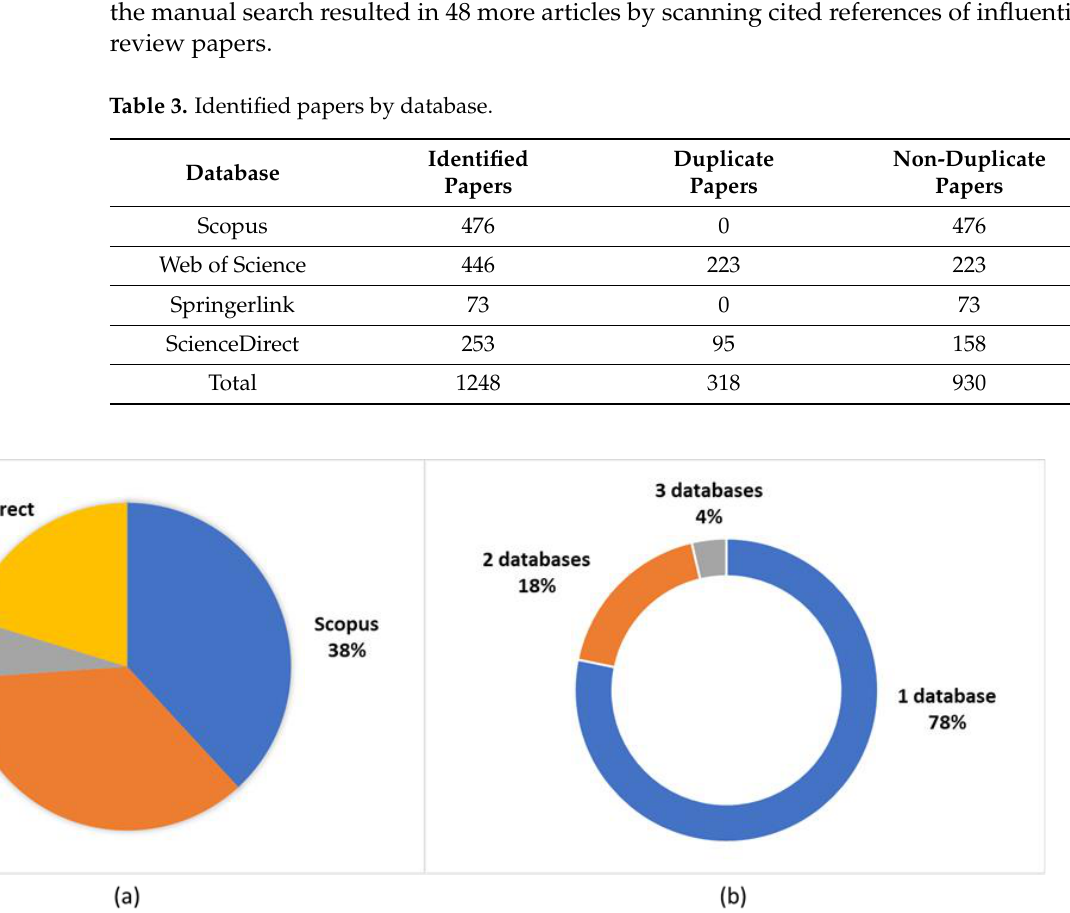
Figure 3. Search by database: ( a ) Database distribution; ( b ) Database duplication. Table 3. Identified papers by database.